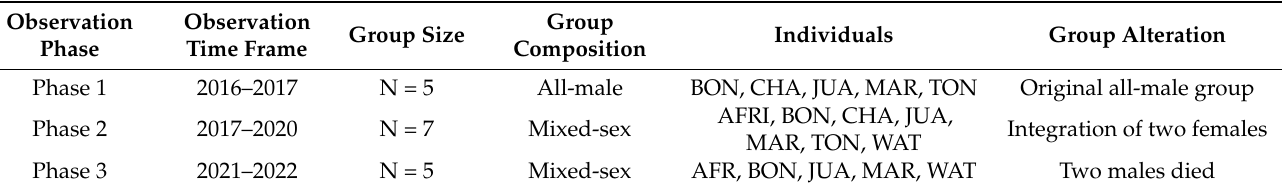
Table 2. Chronology of the different observations time